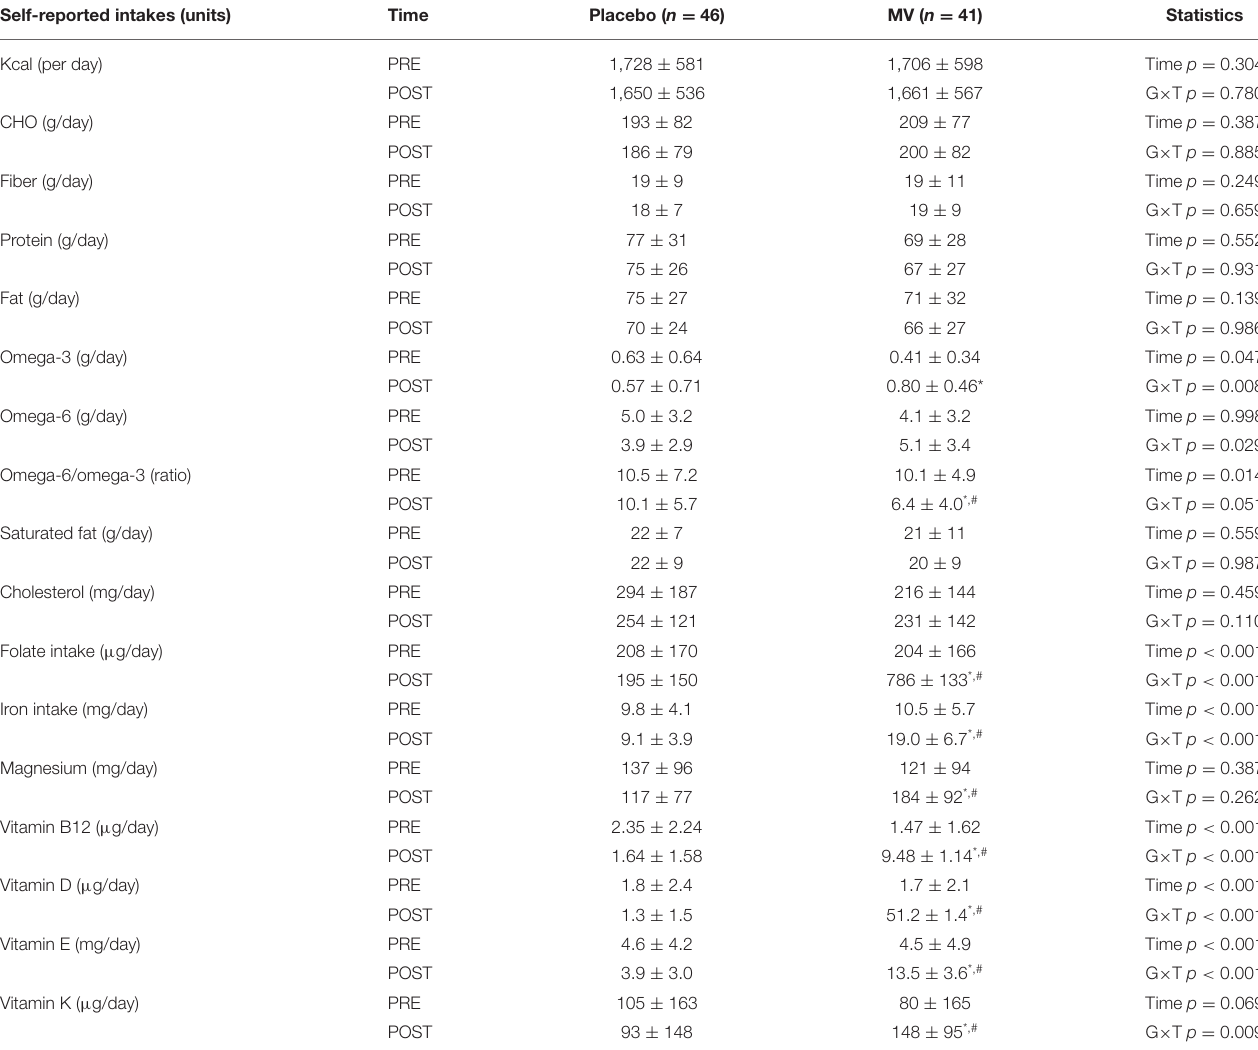
TABLE 5 | Self-reported food intake. Self-reported intakes